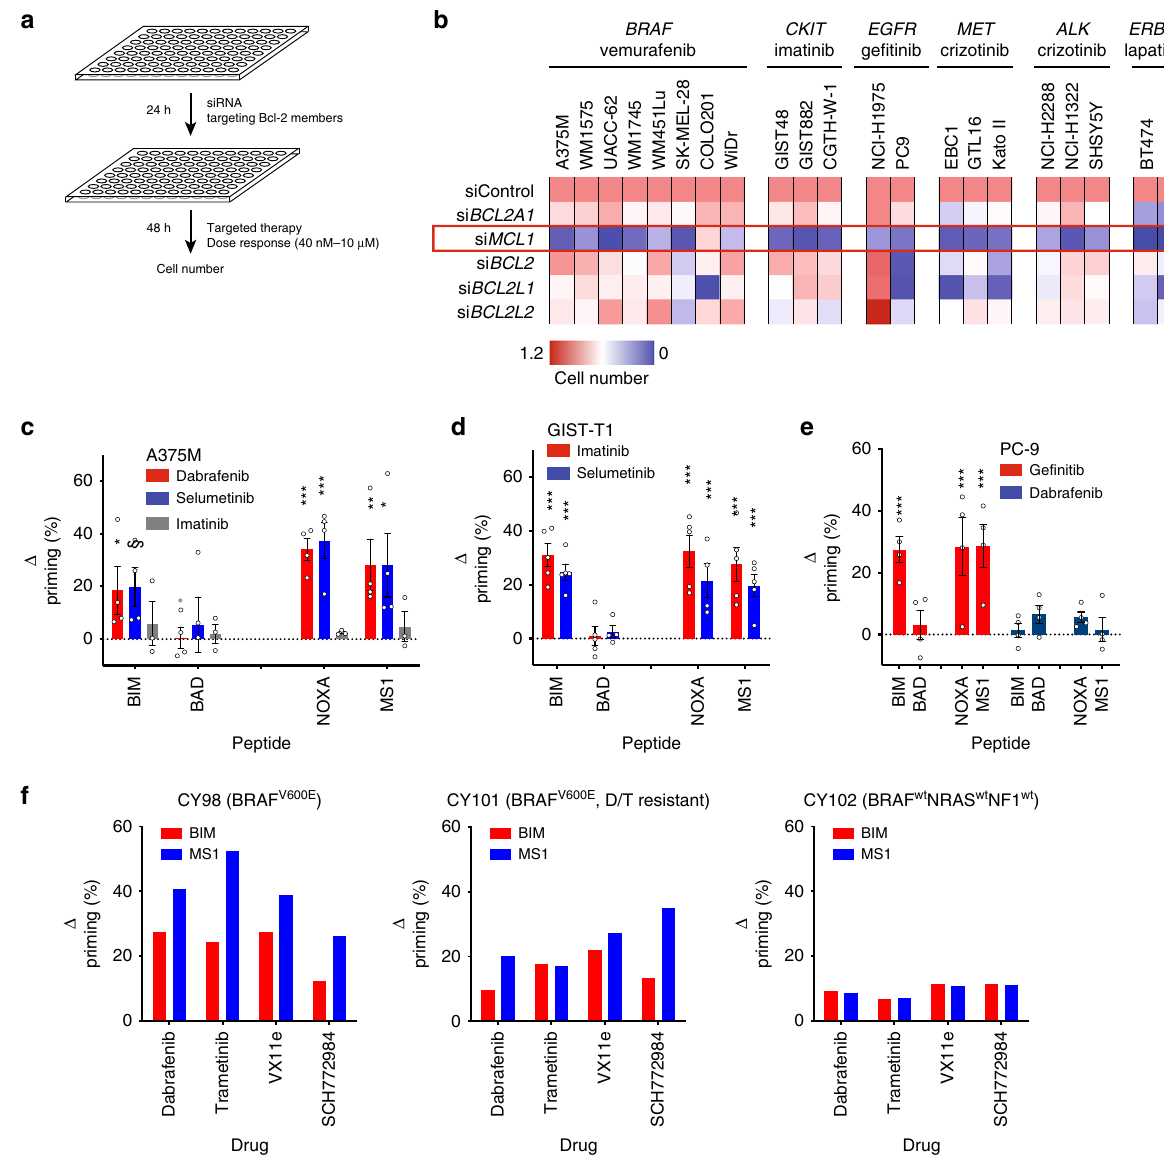
Fig. 1 Targeted therapies induce dependence on MCL-1. a Scheme for sensitization siRNA screen to targeted therapies. b Cell number following targeting of the anti-apoptotic BCL-2 family by siRNA and targeted therapies (10 µ M ), relative to vehicle-treated cells. PLX4720 was used for BRAF -mutant cells, imatinib was used for CKIT -mutant cells, ge fi tinib was used use for EGFR -mutant cells; crizotinib was used for MET- and ALK -mutant cells and lapatinib was used for ERBB2 -ampli fi ed cells. Cell number was normalized to cells transfected with control siRNA and treated with drug vehicle. c , d , e Dynamic BH3 pro fi ling (DBP) of cancer cell lines following 36 h treatment with the indicated drug (1 µ M ). Mitochondrial permeabilization is calculated relative to vehicle- treated cells. Statistical signi fi cance ( n = 4) determined using the Holm – Sidak method. ***, adjusted P value < 0.001 comparing drug treatment vs vehicle control; **, adjusted P value < 0.01; *, adjusted P value < 0.05; §, adjusted P value < 0.1. Comparisons with adjusted P value ≥ 0.1 are designated without any symbol. f DBP pro fi les following BRAF (1 µ M dabrafenib), MEK (0.1 µ M trametinib), and ERK inhibitors (1 µ M VX11e and SCH772984) on freshly obtained cells from melanoma patients ( n = 1). See also Supplementary Fig. 1 and Supplementary Tables 1 and 2. Source data for siRNA screen are provided as a Source Data fi le. Error bars indicate mean ± s.e.m. of indicated replicates BCL-2/BCL-XL/BCL-W (measured with the BAD peptide) did not change with drug treatment. Further, no effect was seen upon treatment of A375M cells with imatinib, indicating that the results were speci fi c to inhibition of the driver oncoprotein. Overall apoptotic response to dabrafenib could be seen within the fi rst 24 h of exposure to dabrafenib and sustained over time